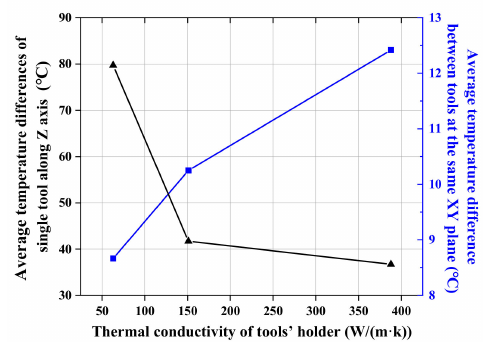
Figure 5. The average value of temperature di ff erence of individual tool and between di ff erent tools at the same XY plane a ff ected by the thermal conductivity of the tools’ holder.